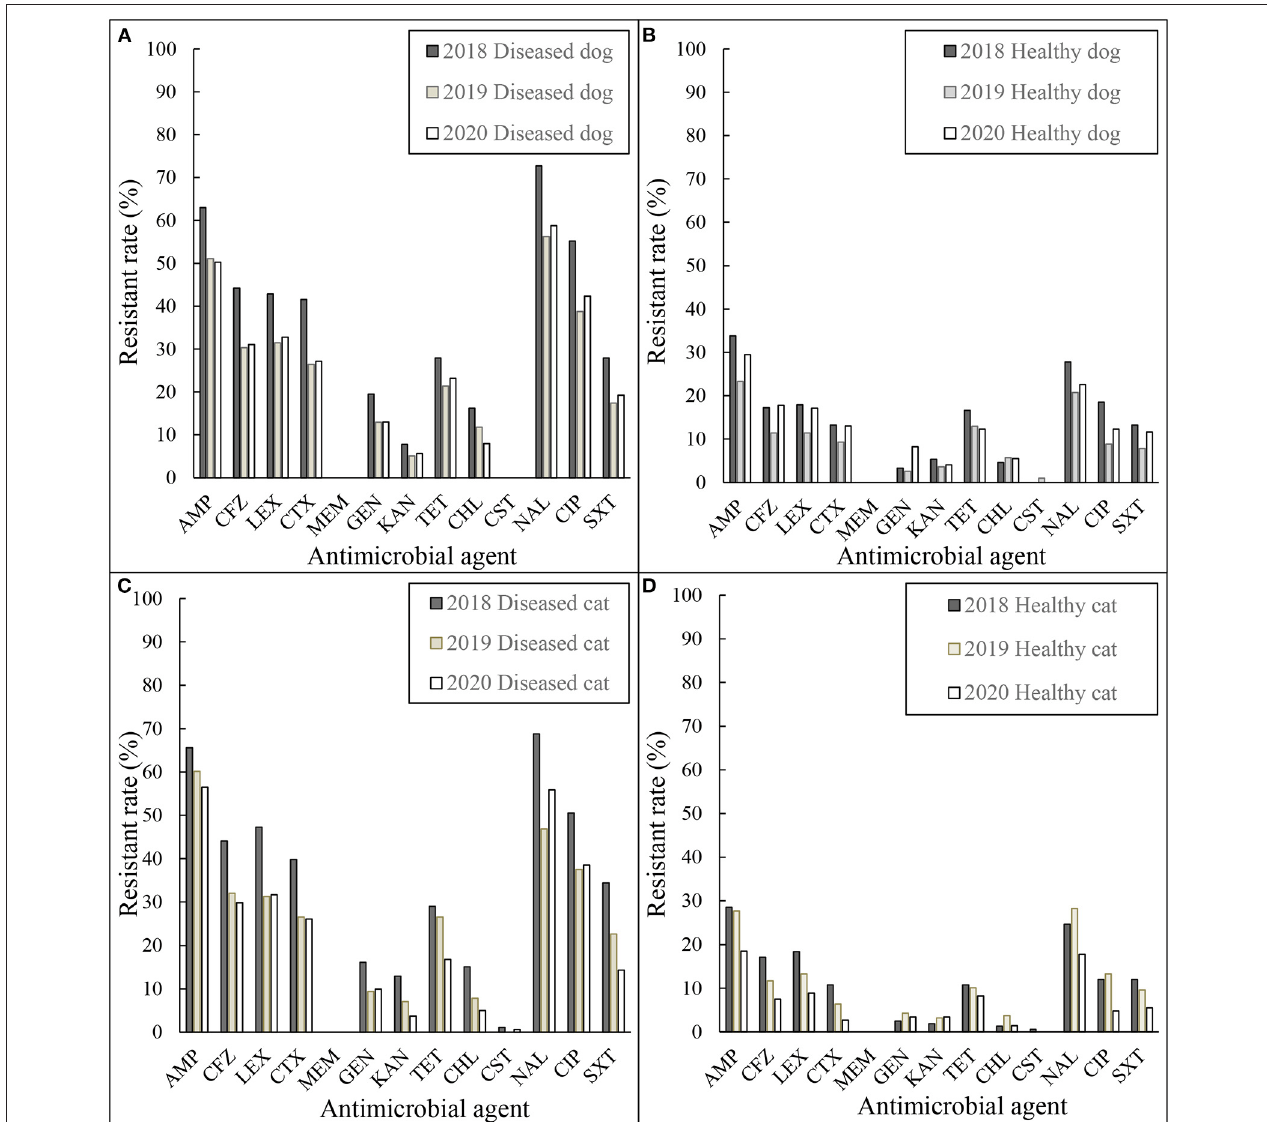
FIGURE 1 | Resistance rates of E. coli (A) diseased dog 2018–2020, (B) healthy dog 2018–2020, (C) diseased cat 2018–2020, and (D) healthy cat 2018–2020. AMP, ampicillin; CFZ, cefazolin; LEX, cephalexin; CTX, cefotaxime; MEM, meropenem; STR, streptomycin; GEN, gentamicin; KAN, kanamycin; TET, tetracycline; CHL, chloramphenicol; CST, colistin; NAL, nalidixic acid; CIP, ciprofloxacin; SXT,